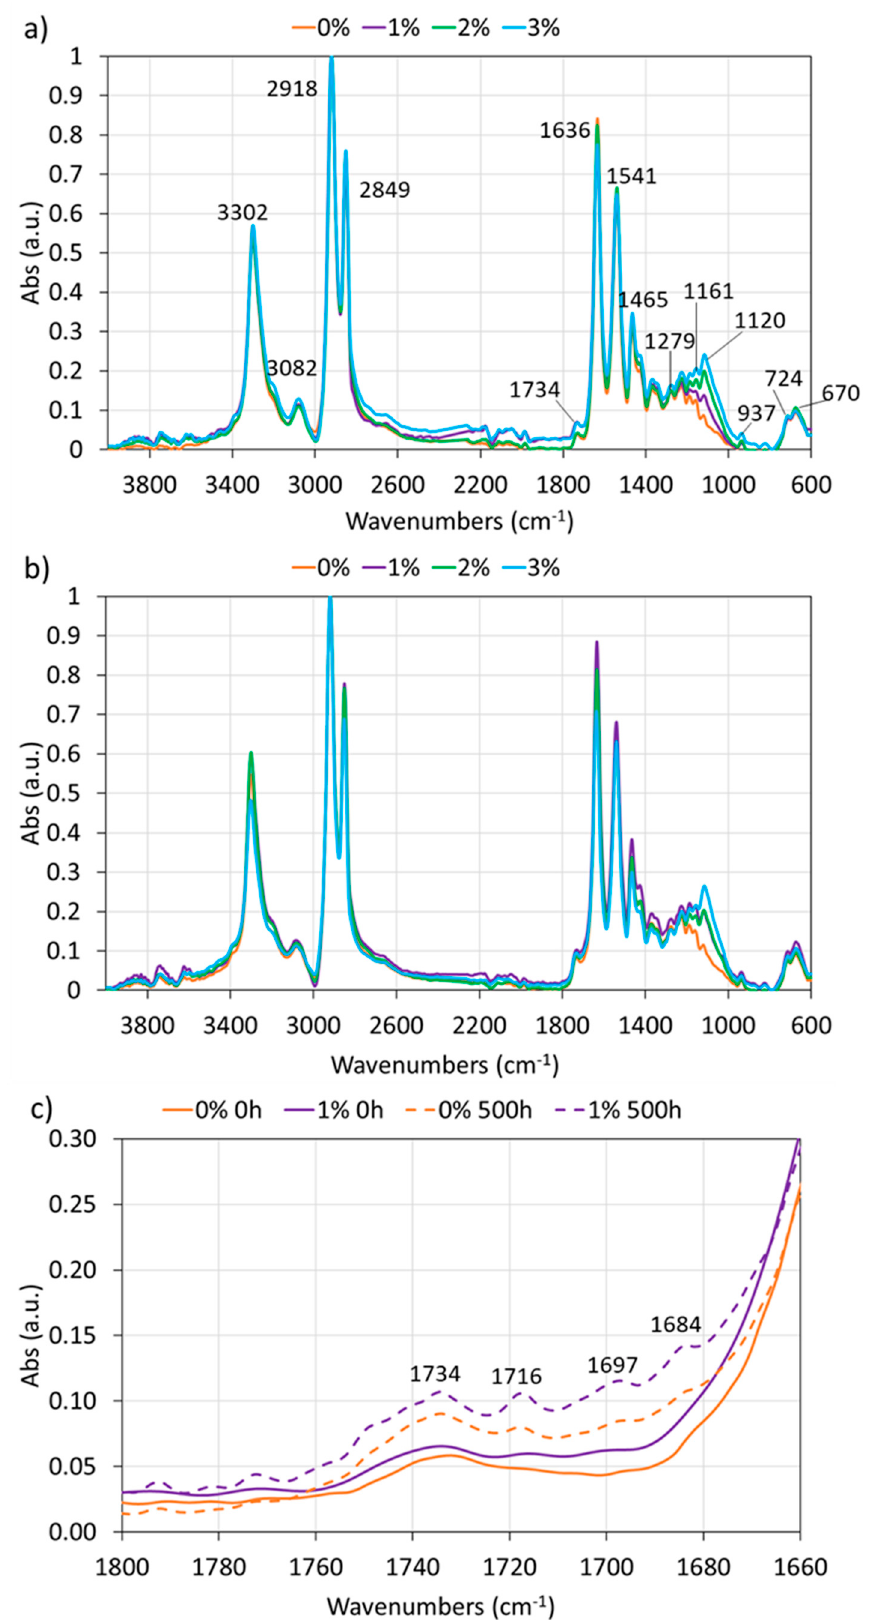
Figure 2. FTIR-ATR spectra of all PA11 coatings at ( a ) 0 h and ( b ) 500 h of xenon exposure, and ( c ) a detail (in the range of 1800–1660 cm − 1 ) of the 0% and 1% coatings before and after xenon exposure.